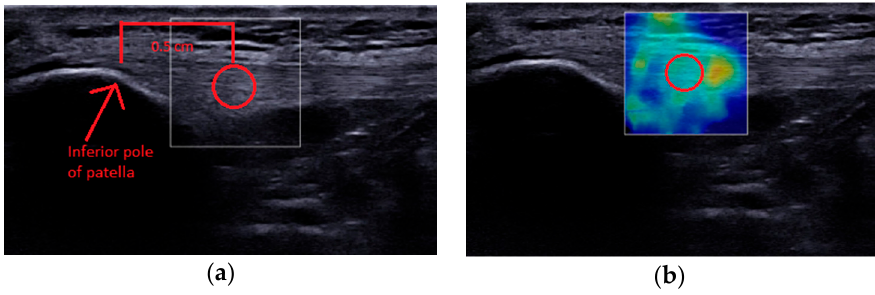
Figure 3. Representative images of a patellar tendon. ( a ) B-mode of the proximal patellar tendon. A 40 mm × 40 mm square box delineated the region of interest (ROI) from the apex of the patella; ( b ) shear modulus mode of the same tendon. The musculoskeletal acquisition mode was used to measure the shear modulus of the patella tendon with the temporal averaging (persistence) and spatial smoothing set to medium and 6, respectively. The color-coded image is displayed, which indicates softer tissue in blue and stiffer in red. A circular circle (Q-box) was centered at 0.5 cm from the apex of patella. Mean shear elastic modulus (kPa) of circular Q-box was computed from the system.